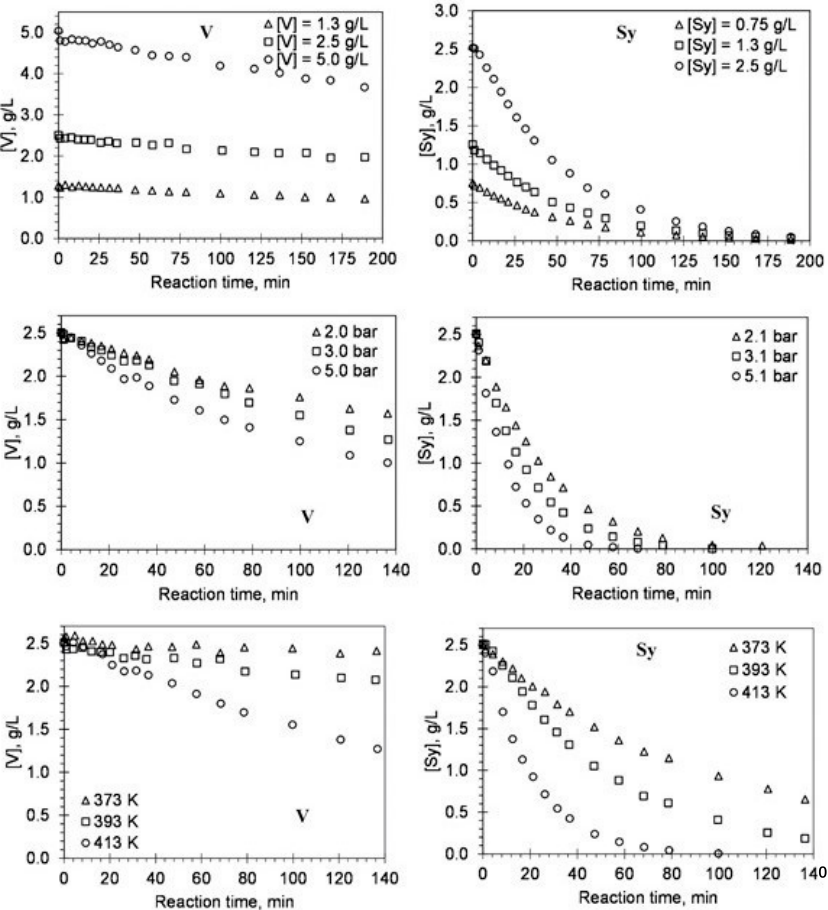
Figure 8. Effect of initial concentration, oxygen partial pressure, and temperature on the degradation as a function of reaction time for V and Sy. The lines represent the fitted kinetic model (experimental conditions: [NaOH] = 80 g/L; p t = 9.8 bar) (reprinted with permission from [59]. Copyright 2019 American Chemical